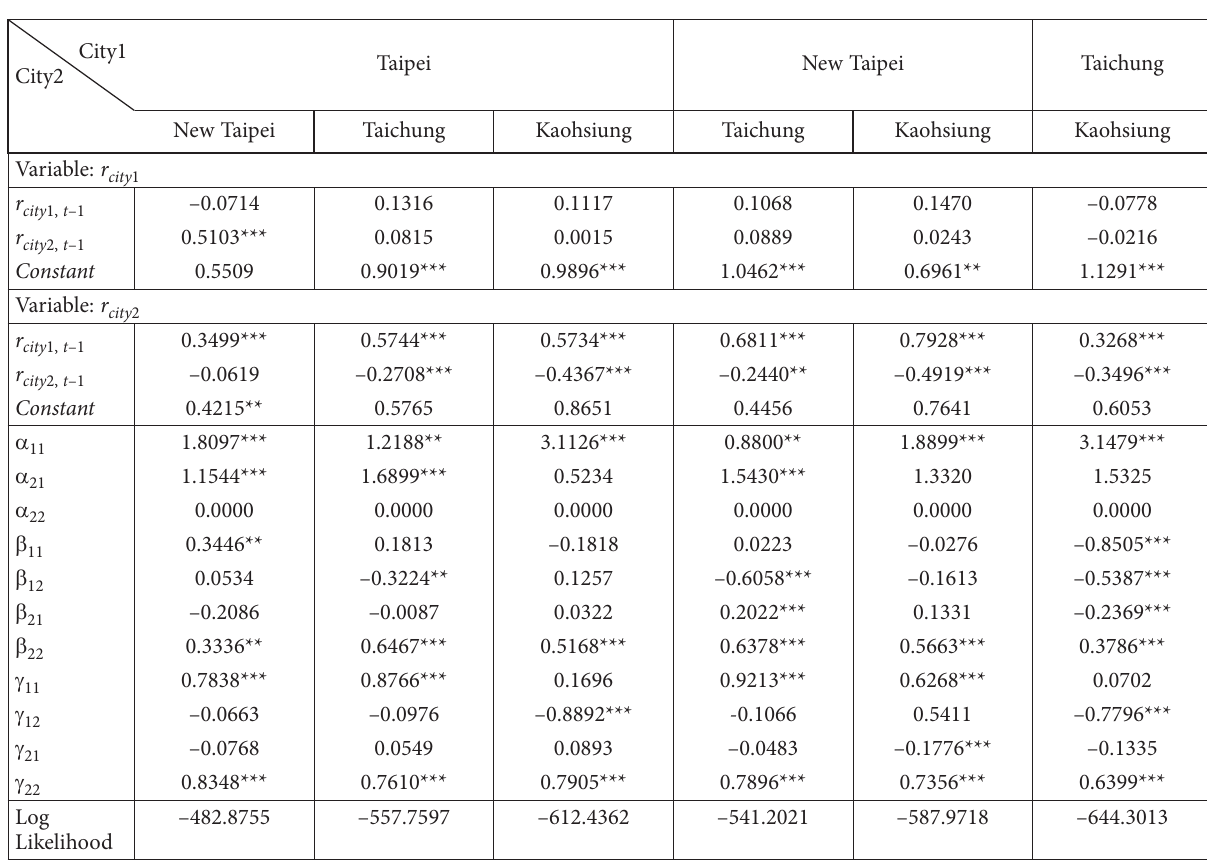
Table 5. VAR-MGARCH models of city pairs